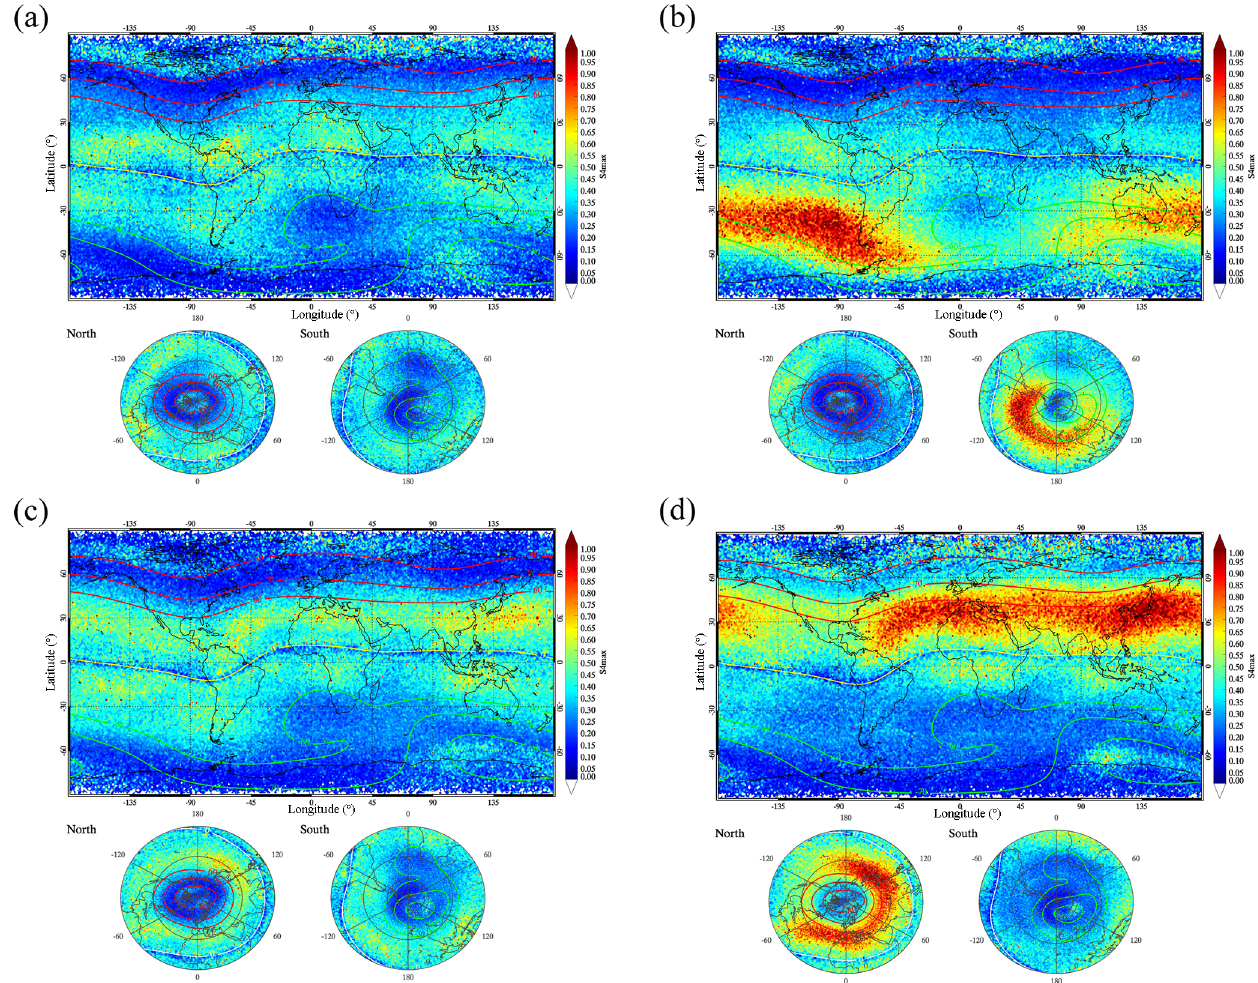
Figure 5. Seasonal variations in E s intensity from 2006 to 2014, with the spatial resolution of a 1 ◦ × 1 ◦ grid. Plots for (a) autumn (September, October, November), (b) winter (December, January, February), (c) spring (March, April, May), and (d) summer (June, July,